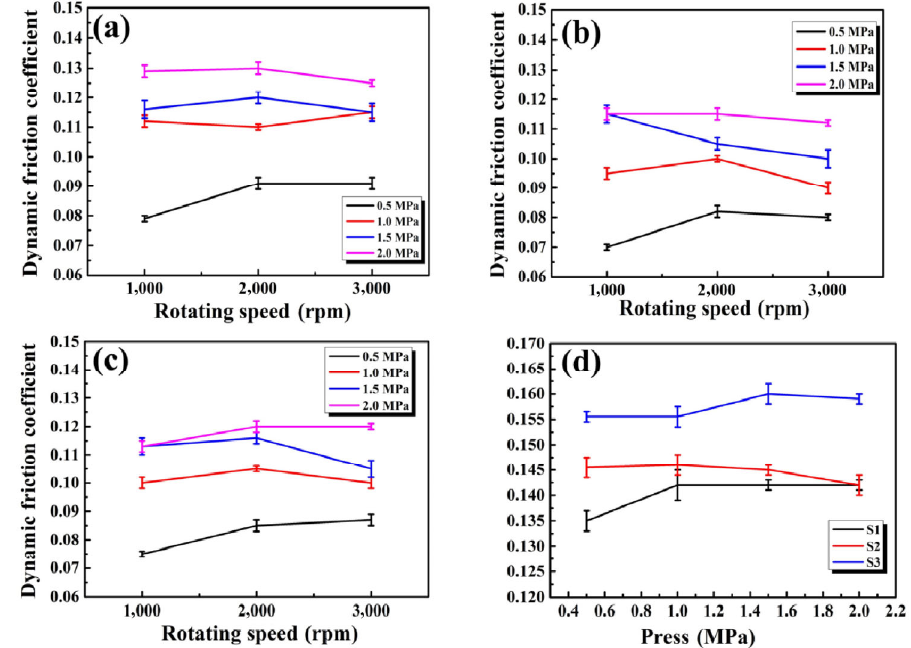
Fig. 8 Dynamic friction coefficient of (a) S1, (b) S2, and (c) S3; (d) static friction coefficient of three